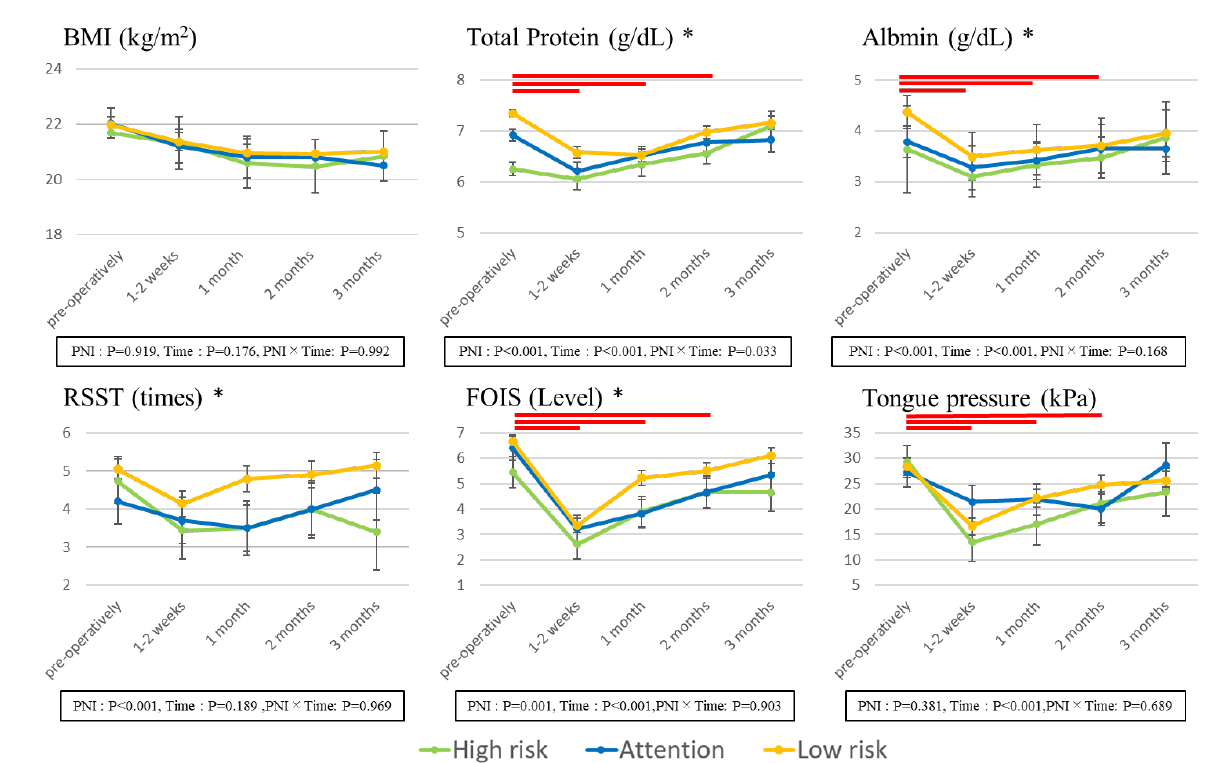
Figure 2. Changes in the nutritional status and condition of dysphagia. BMI, body mass index (kg/m 2 ); albumin, serum albumin; RSST, repetitive swallow saliva test, FOIS; functional oral intake scale. Data are shown as the mean ± S.E. The lower box p -value shows the results of the linear mixed-effects model with the main effects of time (preoperatively, and at 1–2 weeks, 1 month, 2 months, and 3 months postoperatively) and PNI group (High risk, Attention, Low risk) and their interaction effect as fixed effects. When significant differences in main effects were found, multiple comparisons (post hoc test) were performed using the Mann-Whitney-U test. p values were corrected using Bonferroni’s method. The bar indicates that there is a significant difference in comparison to the preoperative value. *: Significant difference between the contraindication and Low-risk groups. There were no groups that differed significantly from the Attention group in any items.